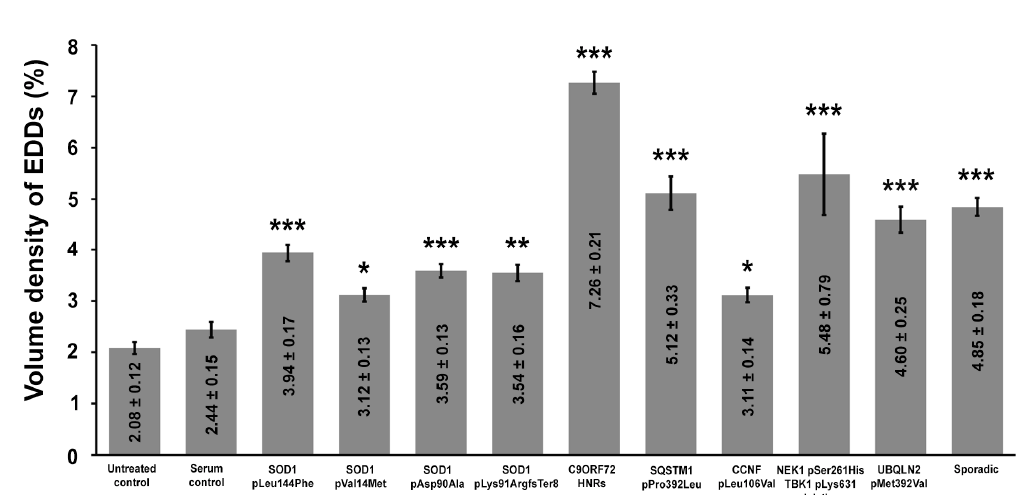
Figure 4. A significant elevation in electron-dense deposits can be observed in motor neurons (MNs) of all amyotrophic lateral sclerosis sera-treated mice. Animals treated with sera from patients with hexanucleotide repeat expansions in the chromosome 9 open reading frame 72 gene showed the highest increase in intracellular calcium levels. Data values are displayed within the bars, and represented by mean value ± standard error of the mean. Statistical evaluation was determined using one-way analysis of the variance with the Bonferroni post hoc pairwise comparison. *: p < 0.05; **: p < 0.01; ***: p < 0.001.